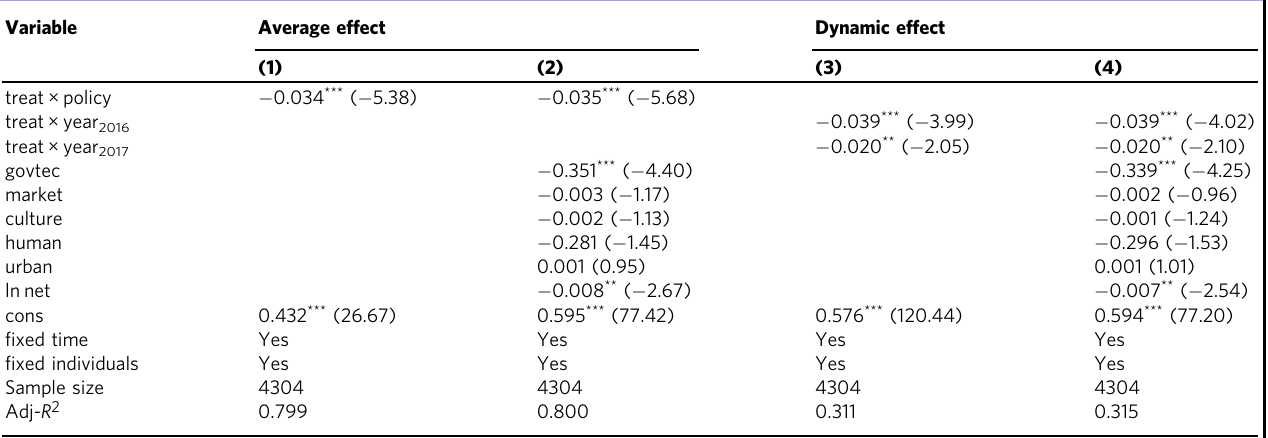
Table 3 Estimation result of the difference in